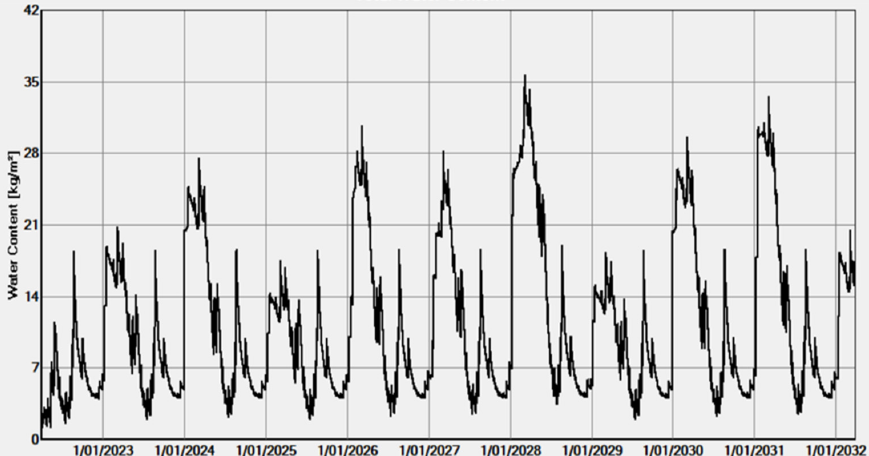
Figure 12. Graph of 10-year fluctuation of moisture content for the wall assembly in west orientation for pliable membrane A with single point.